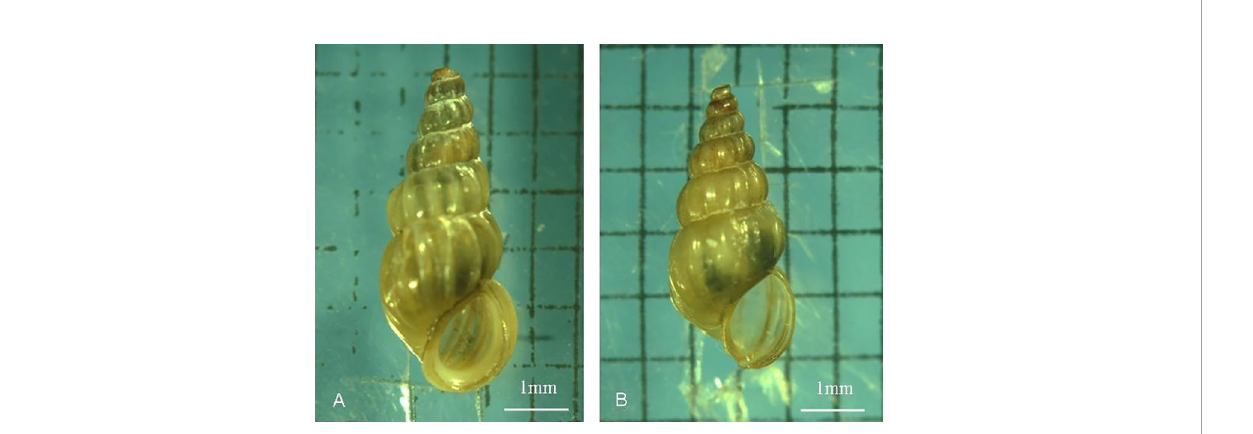
FIGURE 1 Comparison of shell shape changes after 12 generations of O. hupensis snails in the Weishan Lake region. Compared with the Jiangsu snails, the body size of the Shandong snails in the Weishan Lake region decreased, and their shells became thinner. (A) (O. hupensis snails ) ; (B) (O. Weishan snails )